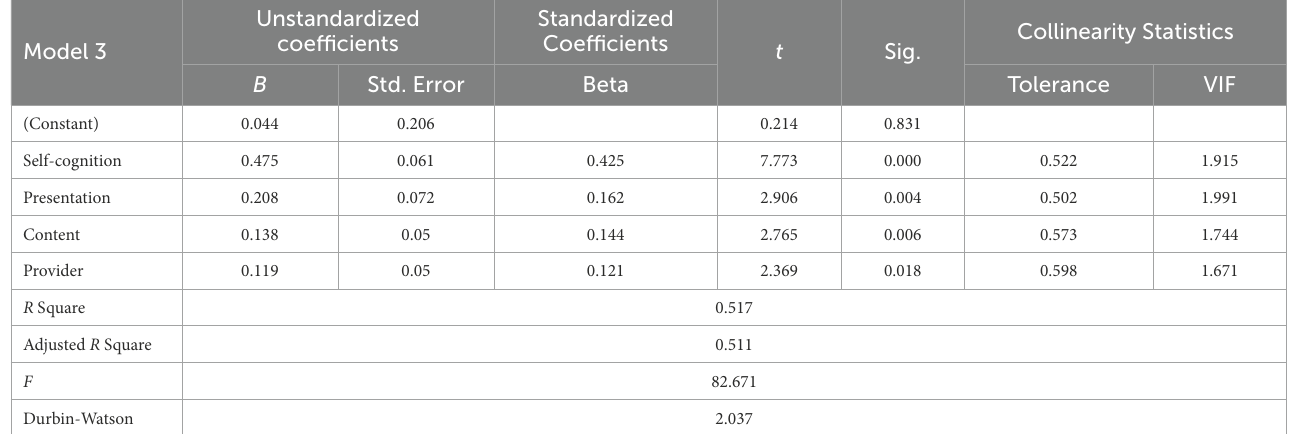
TABLE 7 Regression analysis of predictive variables and conation (a).